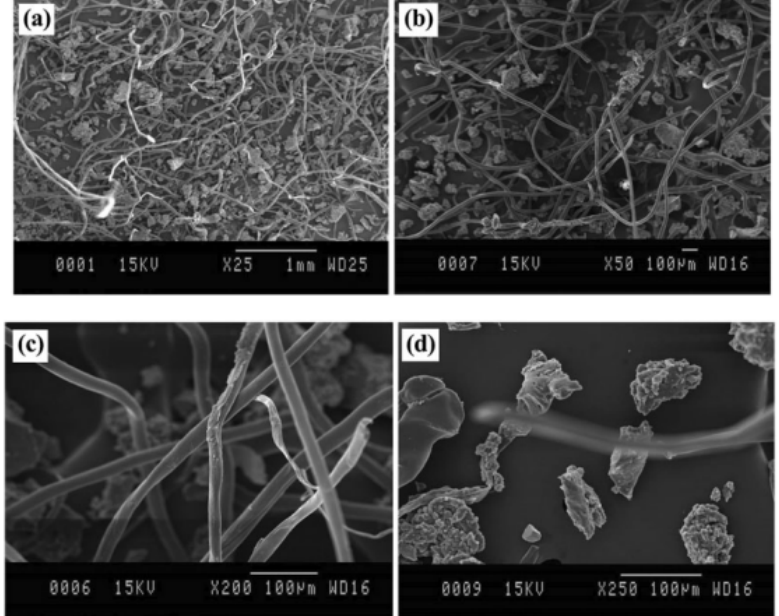
Figure 18. Typical SEM images of WTTF mixed with GTR at different magnifications ( a – d ) [43]. Landi et al. [10] used TGA on WTTF (Figure 19A) to compare the curve with Nylon